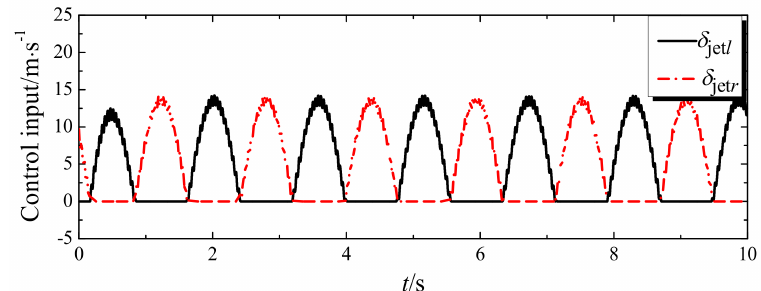
Figure 12. The intermediate control input due to SJA.